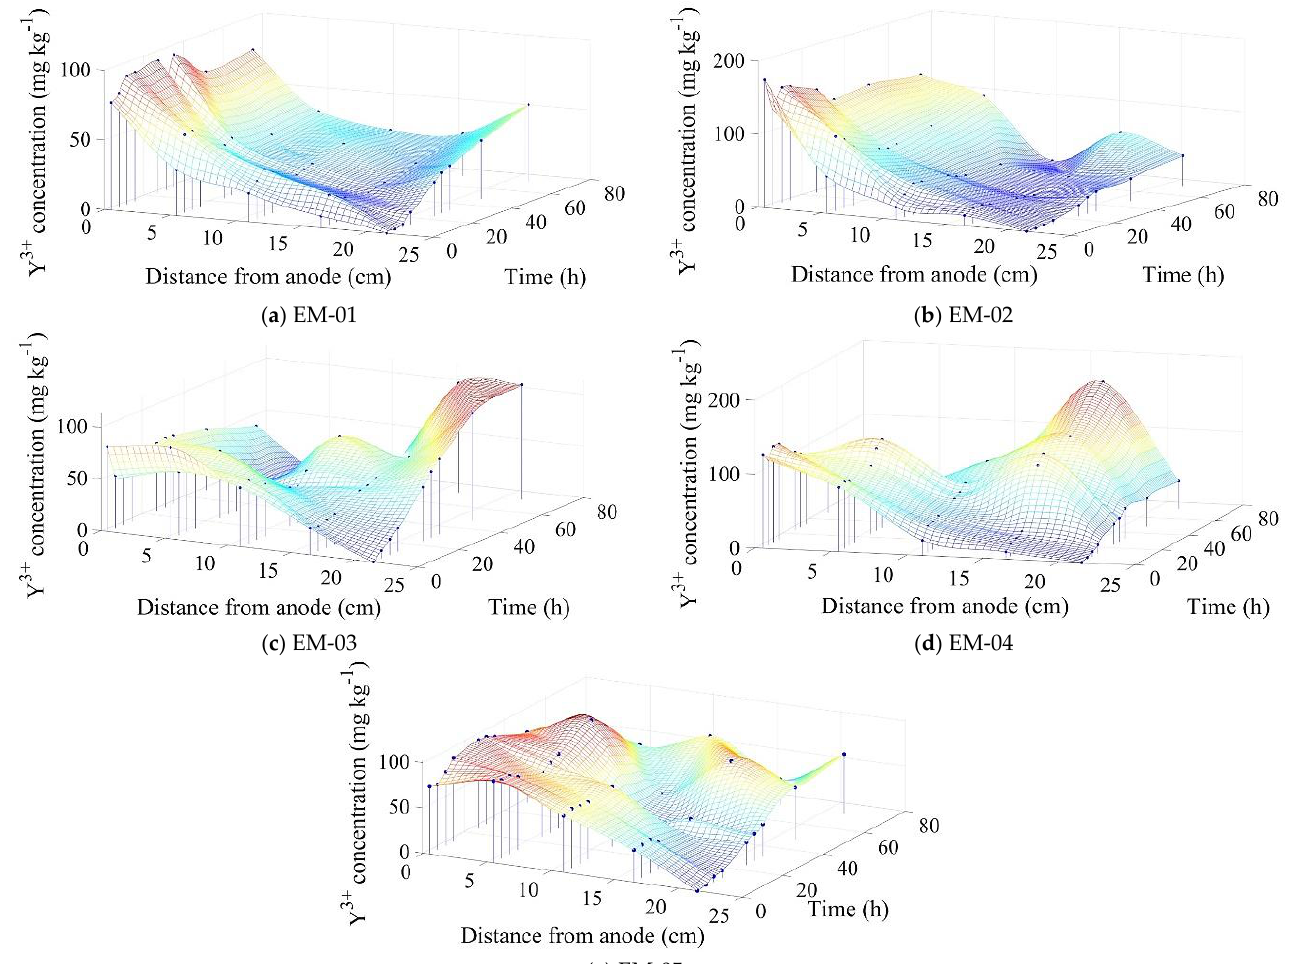
Figure 3. The response surfaces to the Y 3+ migration behavior for the electromining experiments in the synthetic soil.